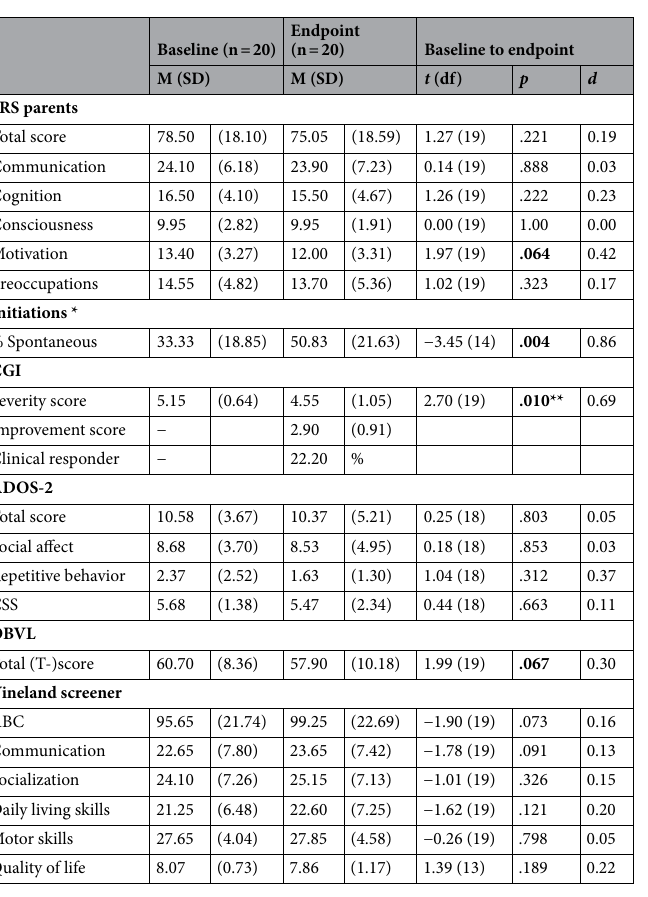
Table 2. Baseline and endpoint outcome comparisons. Vineland ABC score: Vineland screener 0-12 research version Adaptive Behavior Composite score. * As response on therapist-elicited learning opportunities. a Score 1 (very much improved) or score 2 (much improved) on CGI-I. Significance values are in